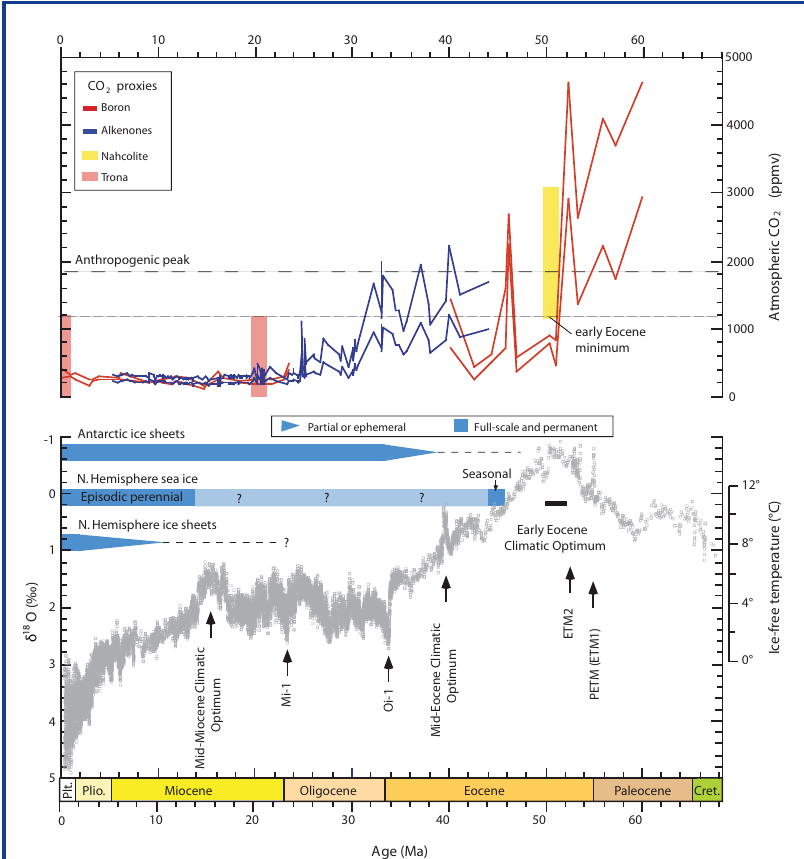
Figure 1. Updated Cenozoic pCO 2 and stacked deep-sea benthic foraminifer oxygen isotope curve for 0 Ma to 65 Ma. NB: Updated from Zachos et al. (2008) and converted to the “Gradstein timescale” (Gradstein et al., 2004). Mi-1 = Miocene isotope Event 1, Oi-1 = Oligocene isotope Event 1, ETM2 = Eocene Thermal Maximum 2, PETM = Paleocene/Eocene Thermal Maximum, ETM1 = Eocene Thermal Maximum